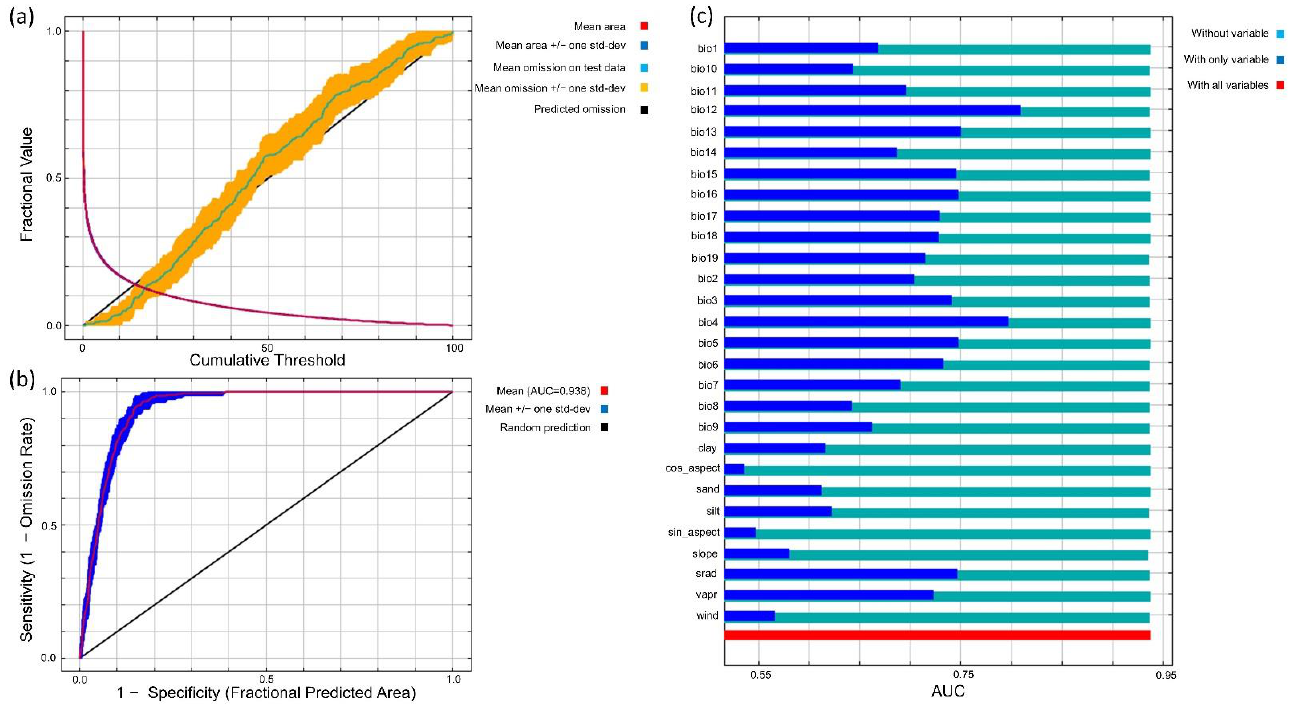
Figure 2. Analysis of omission/commission ( a ) revealed the test omission rate and predicted area as a function of the cumulative threshold. The receiver operating characteristic (ROC) curve ( b ) indicated that the average test area under the curve (AUC) for the replicate runs was 0.938, and the standard deviation was 0.007. The results of the jackknife test of AUC variable importance ( c ) revealed that information gains differed when each variable was isolated.